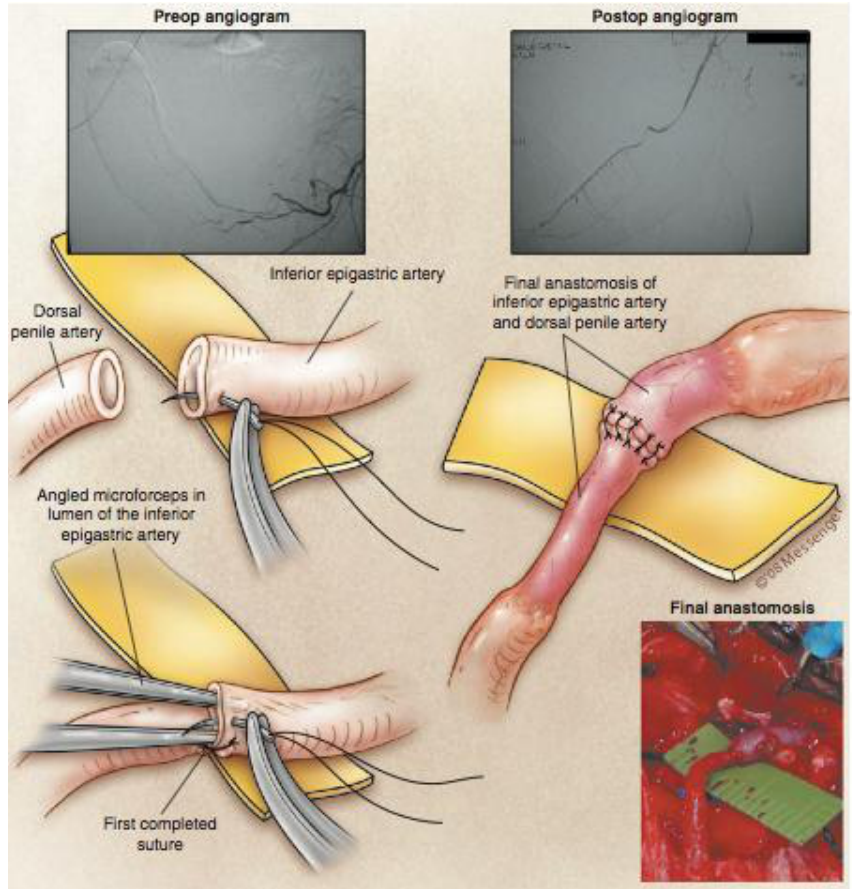
FIGURE 3. Microvascular anastomosis. (From Goldstein, I., Bastuba, M., Lurie, A., and Lubisich, J. [2008] Penile revascularization. J. Sex. Med. 5(9), 2018-2021. With permission.)